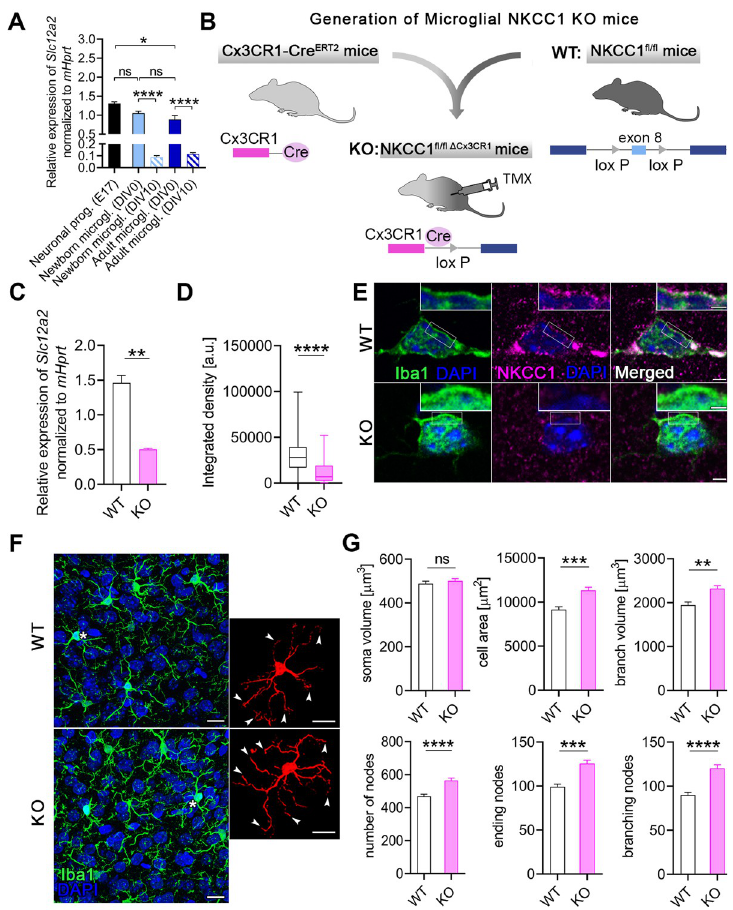
Fig 2. Deletion of microglial NKCC1 markedly impacts on baseline cell morphology and alters transformation to reactive microglia. (A) NKCC1 mRNA expression levels in newborn and adult microglia isolated from C57BL/6J mice compared to neural progenitors derived from E17 embryonic hippocampi. Note that NKCC1 mRNA levels decrease dramatically during in vitro maintenance (DIV10). ( B) We generated a novel microglia-specific conditional NKCC1 KO transgenic mouse line by crossing NKCC1 fl/fl (exon 8 of the Slc12a2 gene was flanked with lox P sites) and Cx3CR1-Cre ERT2 mice. ( C) NKCC1 mRNA levels in isolated NKCC1 KO microglia was markedly reduced in comparison to WT cells. ( D, E) NKCC1 protein expression in a large number of randomly sampled NKCC1 KO microglia cells is markedly reduced compared to WT cells. Inserts show plasma membrane localization of NKCC1. ( F, G) Automated morphological analysis and maximum intensity projections of confocal images. Inserts show cells marked with white asterisks in 3D. Arrowheads indicate altered branch structure of NKCC1 KO microglia. Automated morphological analysis shows that features of NKCC1-deficient microglia significantly differ from WT microglia. (A) One-way ANOVA, followed by Holm–Sidak’s post hoc test. N (Neuronal progenitor) = 3, N (Newborn microglia DIV0) = 6, N (Newborn microglia DIV10) = 5, N (Adult microglia DIV0) = 7, N (Adult microglia DIV10) = 6. �� : p < 0.01. ( C) Unpaired t test, N = 3/group. �� : p < 0.01. ( D) Mann–Whitney test, N (WT) = 142 cells from 2 mice, N (KO) = 83 cells from 1 mouse. ���� : p < 0.0001. ( E) Scale: 2 μ m, in inserts: 1 μ m. ( F, G) Scale: 25 μ m; Mann–Whitney test, N (WT) = 162 cells from 3 mice, N (KO) = 281 cells from 5 mice. �� : p < 0.01, ��� : p < 0.001, ���� : p < 0.0001. Data underlying this figure can be found in S1 Data. DIV, days in vitro; E17; embryonic day 17 KO, knockout; ns, not significant; TMX, tamoxifen; WT, wild